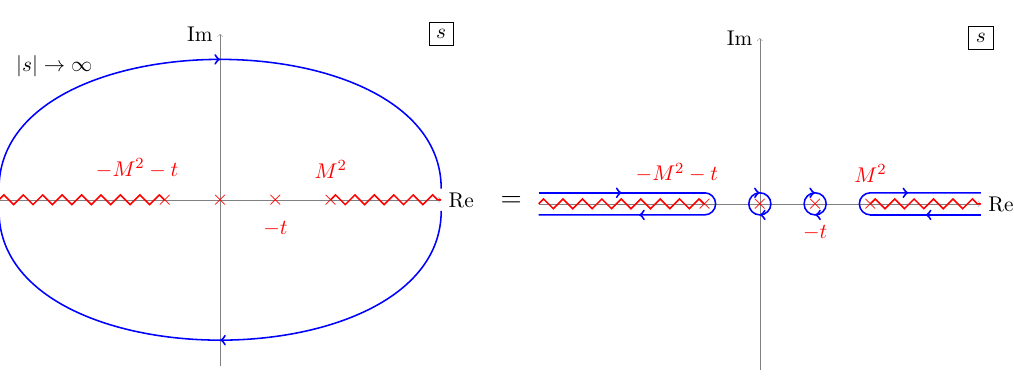
Figure 3. Contour deformation which gives the sum rule (2.14) when low-energy loops are neglected: the integral over arcs at infinity vanishes, thus relating low-energy data and heavy